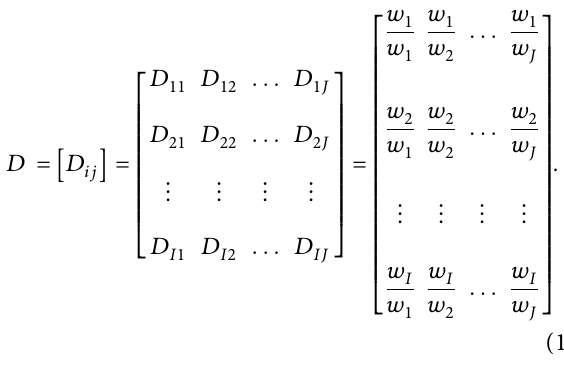
Figure 1: Hierarchical structure of public safety rating-related dimensions and the upper right triangle, and the diagonal value ( D ii ) from the upper left corner to the bottom right corner is 1.